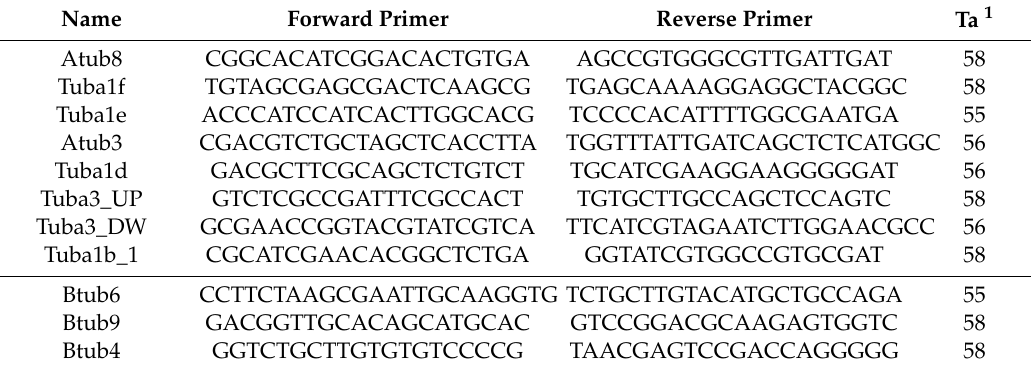
Table 7. Oligonucleotides used as primers for the genomic DNA amplifications.